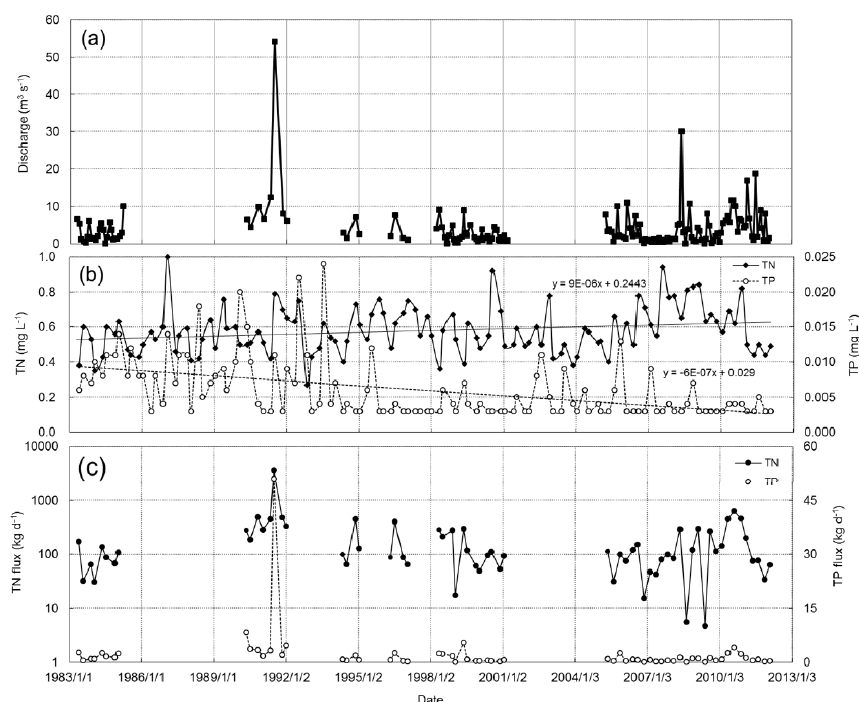
Figure 5. Variations in discharge (a) , concentrations of total nitrogen (TN) and total phosphorus (TP) (b) and estimated fluxes of TN and TP (c) from